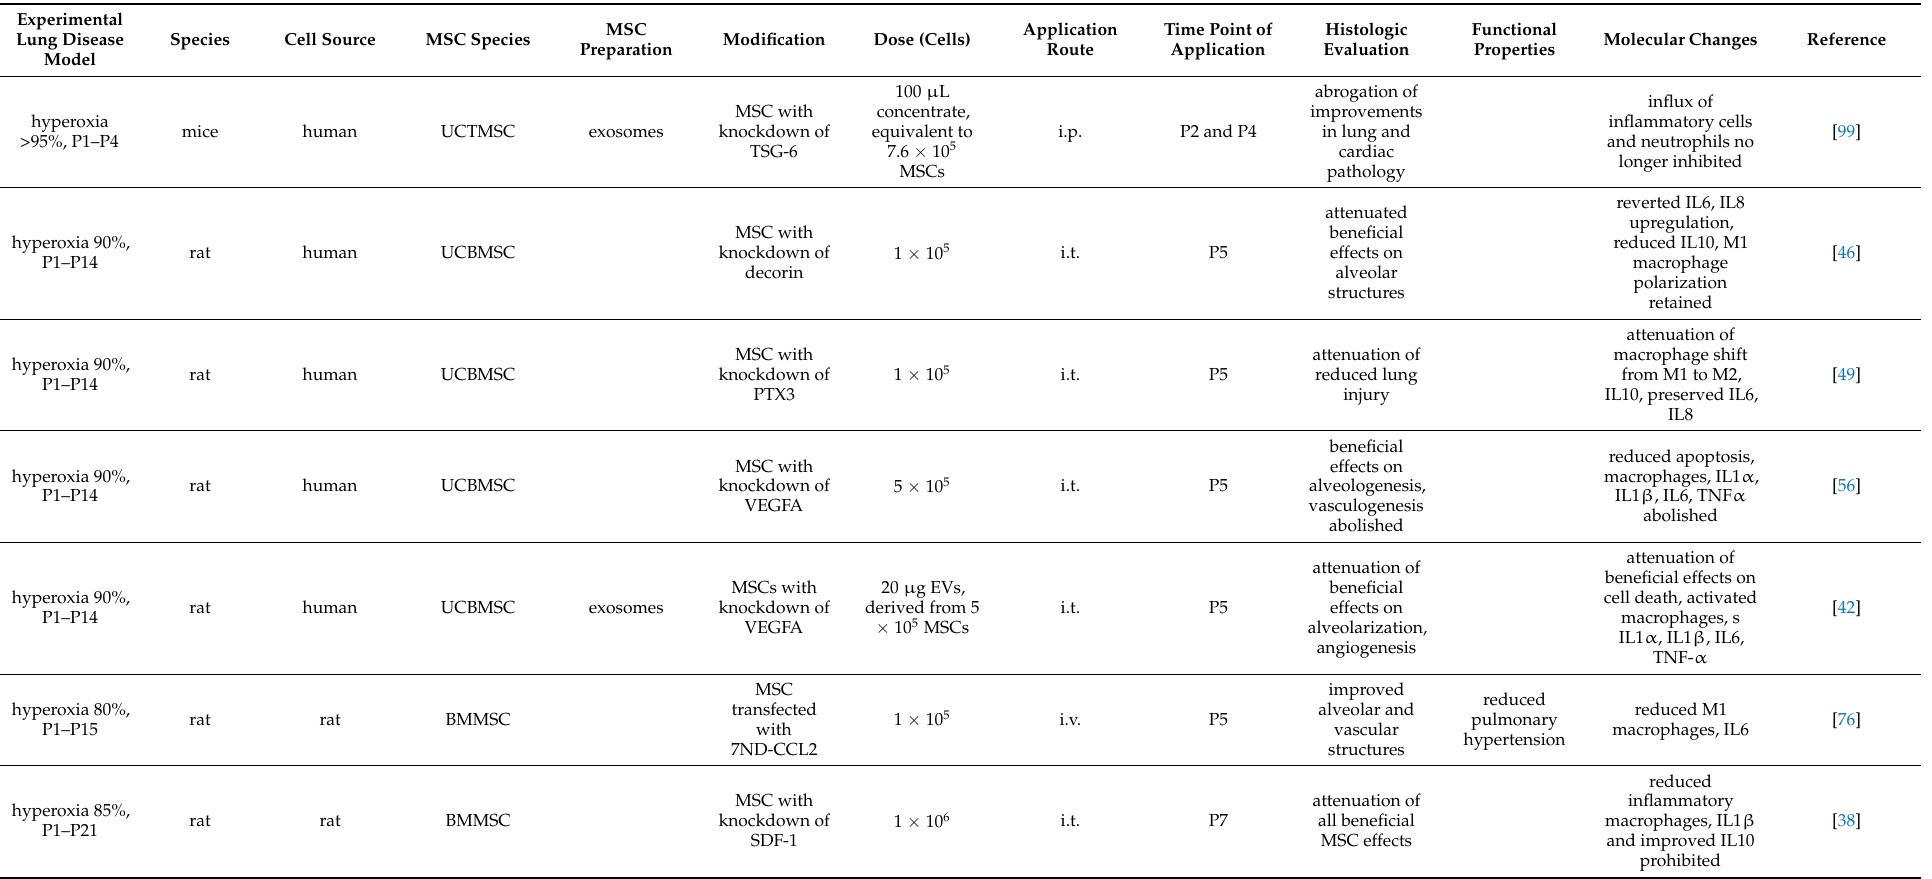
Table 8. Effects of MSC transduction before application in the BPD rodent